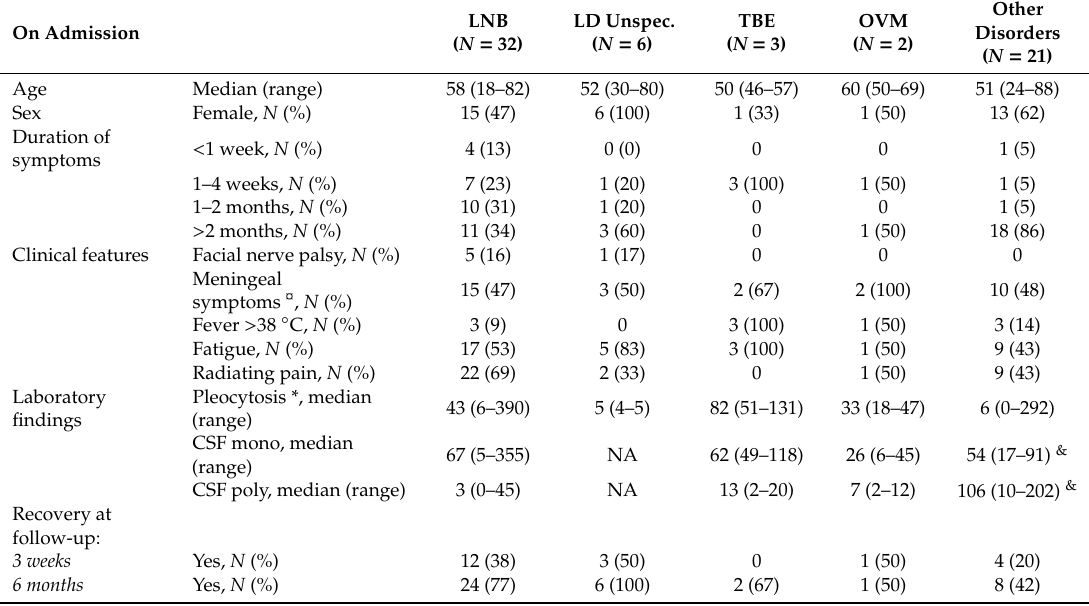
Table 2. Characteristics of adult